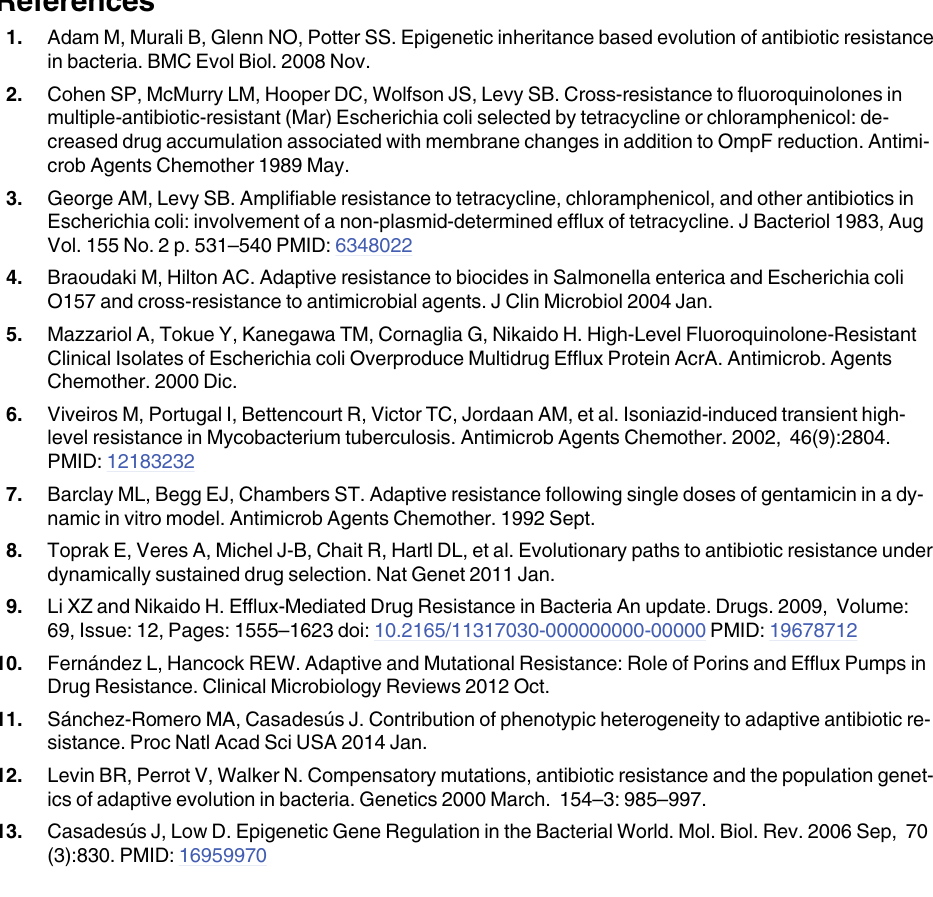
second column shows the values used to obtain the results presented in the main text, while the third column shows the values used for the alternative scenarios (presented in the SI). In the latter case the values that are different from those in the original model are shaded in gray. S2 Table. Meaning and interpretation of parameters. This table lists all the parameters of the model and gives their biological interpretation. S3 Table. Parameters for the complete network. Values of the parameters used for the nu- merical simulations of the complete Mar system depicted in Fig. 1A of the main